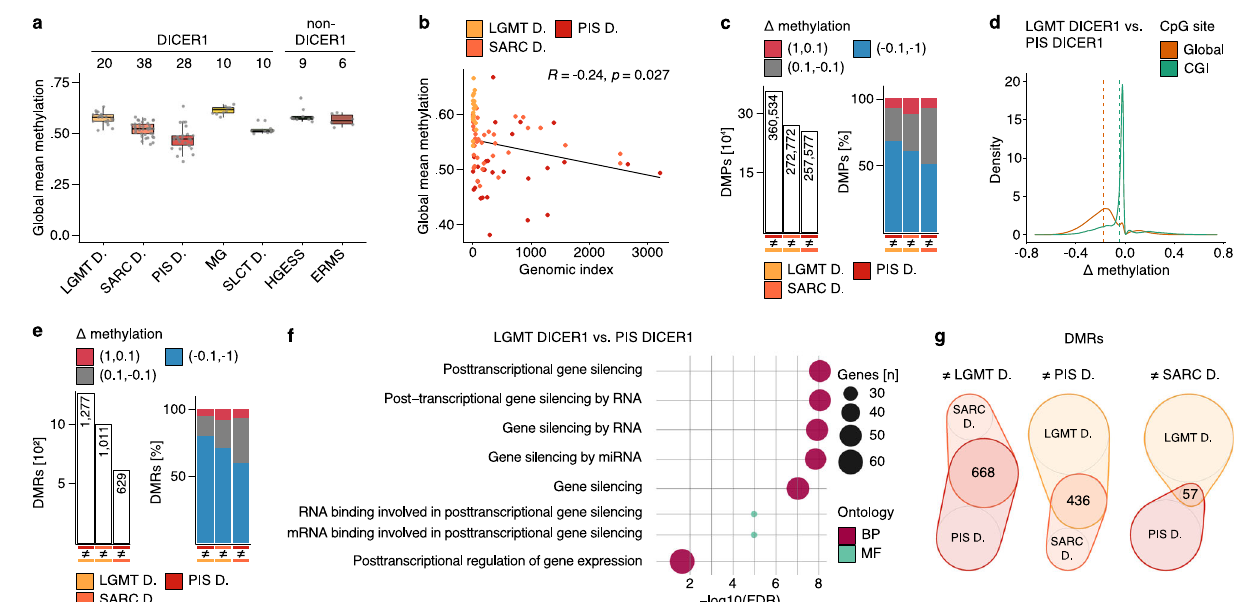
Fig. 4 | Sarcomas with DICER1 alteration show a genome-wide hypomethyla- tion signature. a Global mean DNA methylation levels per sample across CpGs outsideofCGIs(CpG-denseregionsinCGIsareexcludedforglobalquanti fi cations) for LGMT DICER1, SARC DICER1 and PIS DICER1, MG and SLCT DICER1, as well as ERMS and HGESS (Supplementary Table 4). Black lines mark the median, edges of boxesdenoteinterquartilerange(IQR),andverticallinesindicate1.5×IQR.Number of samples analyzed, and DICER1-association are indicated at the top. b Global meanmethylationandgenomicindexshowaninversecorrelationinLGMTDICER1, SARC DICER1 and PIS DICER1. Correlation was determined using the Pearson cor- relation coef fi cient. c Absolute number, and difference ( Δ ) in methylation of dif- ferentially methylated probes (DMPs) identi fi ed in a group-wise comparison of clusters of mesenchymal neoplasms with DICER1 alteration (LGMT DICER1, SARC DICER1 and PIS DICER1) (Supplementary Table 5). Δ in methylation indicates the differencebetweenindividualbetavalues:Redindicatesapositive Δ inmethylation